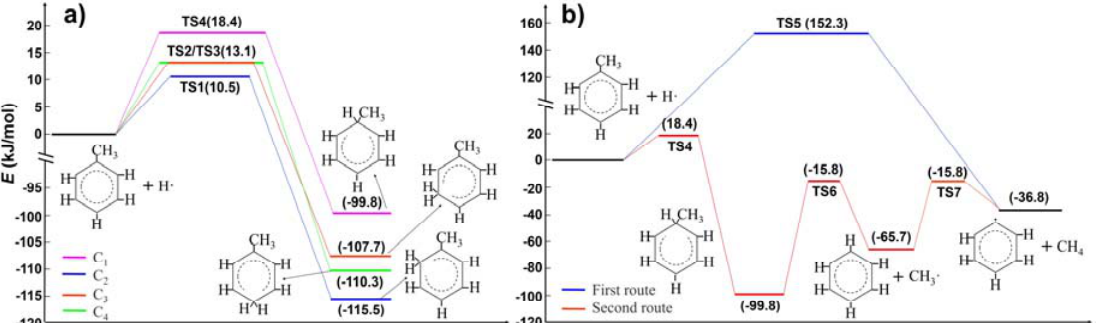
Figure 2. The energy profiles: ( a ) Hydrogenation of toluene (the original reactant) by the first hydrogen atom; ( b ) hydrocracking of toluene (the original reactant) by the first hydrogen atom.